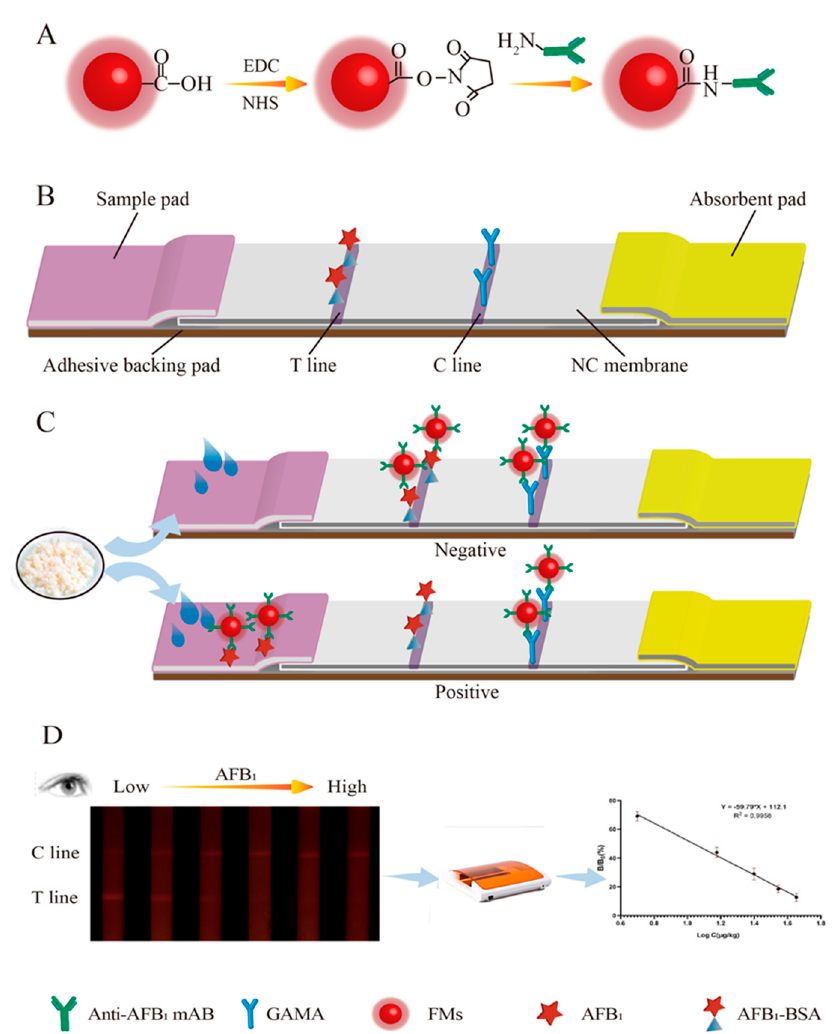
Figure 1. Schematic diagram of FMs-LFA for AFB 1 detection in distillers’ grains: ( A ) the preparation principle of FMs-AFB 1 Ab immunoprobe; ( B ) the structure of test strip; ( C ) the detection principle of test strip; and ( D ) the qualitative and quantitative test results.